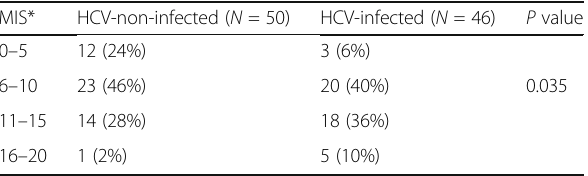
Table 5 The frequency distribution of the Malnutrition- Inflammation Score in HCV-infected group compared to non- infected group